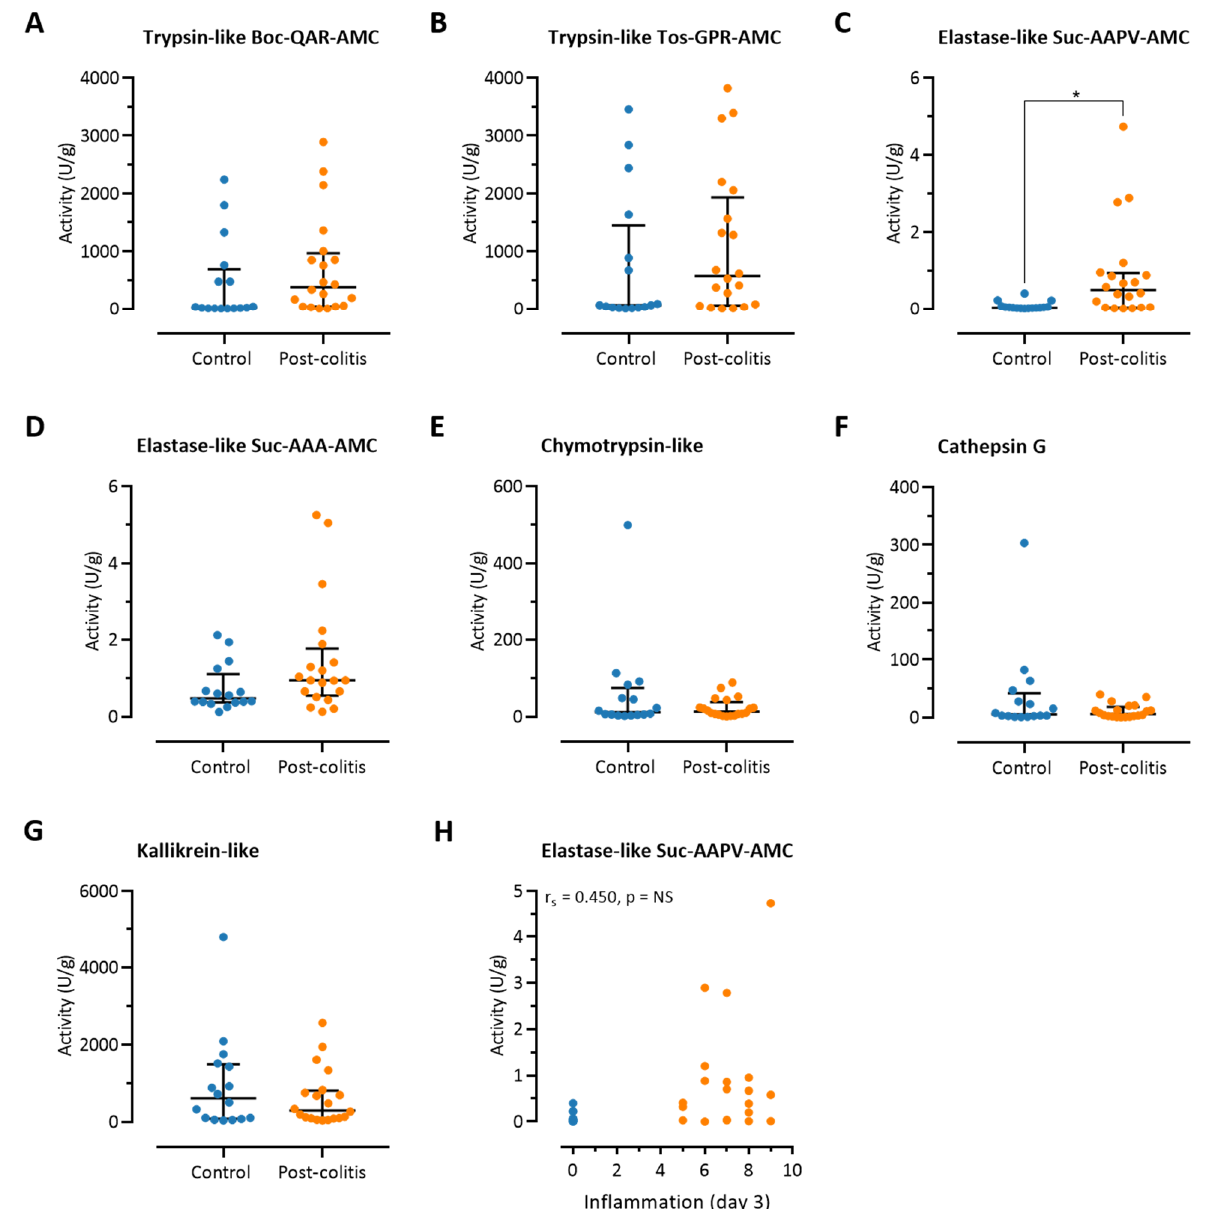
Figure 4. Proteolytic activities in fecal samples of post-colitis and control rats. ( A ) Trypsin-like activity assessed using Boc-Gln-Ala-Arg-AMC. ( B ) Trypsin-like activity assessed using Tos-Gly-Pro-Arg-AMC. ( C ) Elastase-like activity assessed using Suc-Ala-Ala-Pro-Val-AMC. ( D ) Elastase-like activity assessed using Suc-Ala-Ala-Ala-AMC. ( E ) Chymotrypsin-like activity. ( F ) Cathepsin G activity. ( G ) Kallikrein activity. Proteolytic activities were analyzed using Mann–Whitney U tests with Bonferroni correction for multiplicity; n = 16–20 per group. Data are presented including the median and IQR. ( H ) Correlation between the severity of inflammation in the acute phase of colitis (day 3) and elastase-like activity using Suc-Ala-Ala-Pro-Val-AMC. Correlations were assessed using Spearman’s rank order correlation coefficient, employing the Holm–Bonferroni method to correct for multiplicity. Note: * p < 0.05, significantly different from control. NS, non-significant.